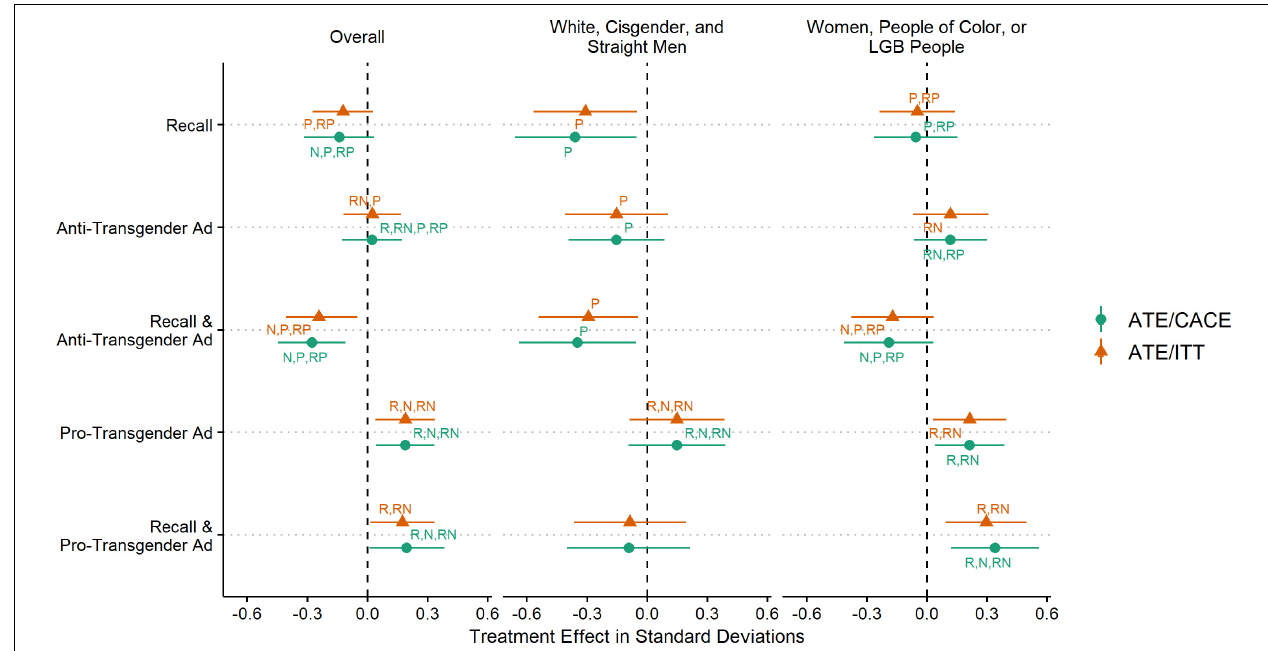
FIGURE 1 | Treatment effects on attitudes toward transgender people and rights scale, Study 1 (ATEs/ITTs and CACEs). R, recall; N, anti-transgender ad; RN, recall and anti-transgender ad; P, pro-transgender ad; RP, recall and pro-transgender ad. Annotation signifies a significant difference in treatment effects at p < 0.05 (one-tailed); 90% confidence intervals represented by error